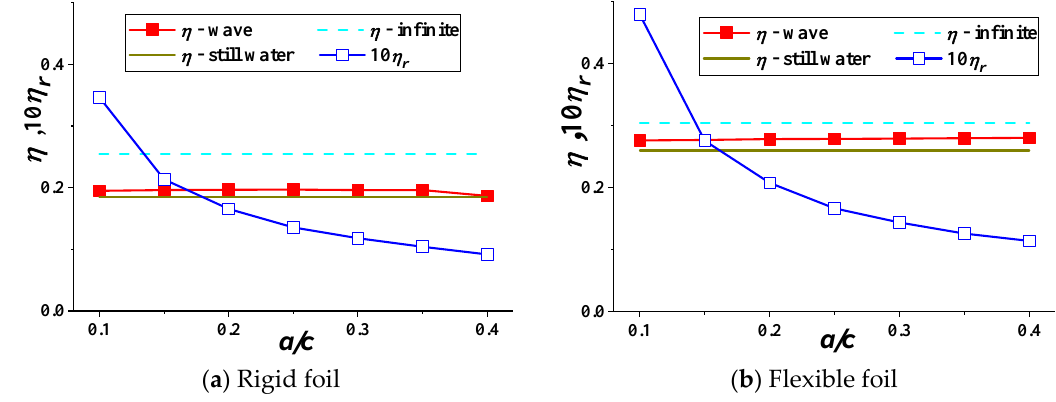
Figure 9. The percentage of wave energy recovery η r and propulsive efficiency η for the foil versus non-dimensional wave amplitudes.